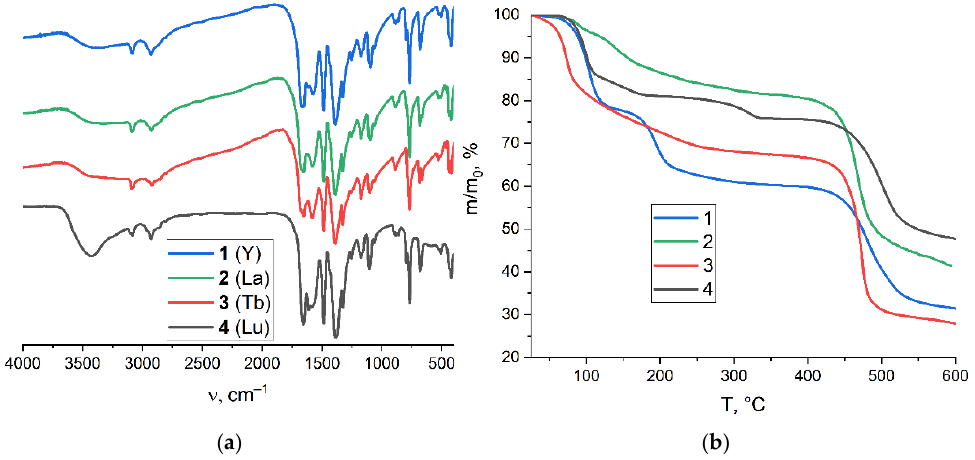
Figure 3. IR spectra for compounds 1 – 4 ( a ). TG plots for compounds 1 – 4 ( b ). According to thermo- gravimetric analyses (TGA, Figure 3b), all the compounds slowly lose their guest and coordinated solvent molecules at heating temperatures of up to 340 °C. The stepwise curve for 1 shows the loss of 3.5 guest DMF molecules at ca . 100 °C (22% weight loss; calculated for 3.5DMF – 18%) and then four coordinated DMF molecules at ca . 190 °C (18% weight loss; calculated for 4DMF – 21%). The total weight losses for 2 and 3 at 400 °C correspond to four and seven DMF molecules, respectively. The stepwise TGA curve for 4 demonstrates the 20% weight loss in the 100 – 140 °C interval, corre- sponding to ~3.6 guest DMF molecules (calculated for 3.6 guest DMF – 20%) followed by the removal of two coordinated H 2 O molecules at ca . 310 °C (4% weight loss; calculated for 2H 2 O – 3%). Therefore, the thermogravimetric analysis agrees well with the elemental analysis data, except for in the case of 2 , where some level of underestimation of the guest content based on TGA data might be at- tributed to the weathering of two DMF guest molecules during sample handling. An irreversible framework decomposition in 1 – 4 starts at ca . 440 °C. Such thermal stabilities of the coordination frameworks are comparable to those for other reported Ln(III)-based MOFs based on ttdc 2 − ligand and its derivatives [39,41,44,52].